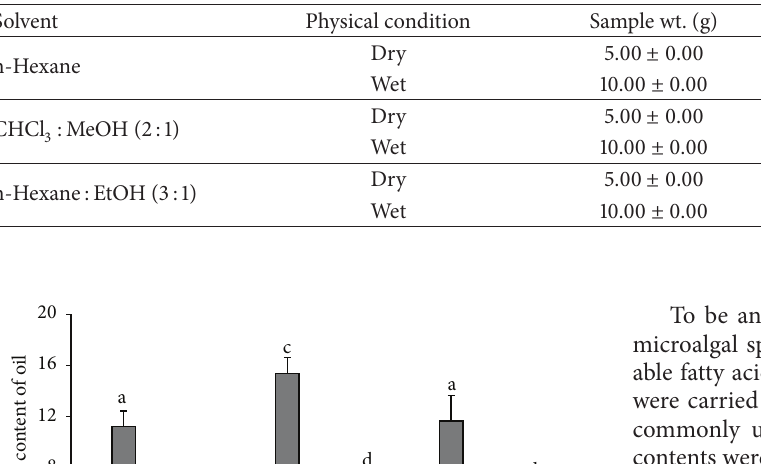
Table 1: Percentage of total oil recovered by the three different solvents.